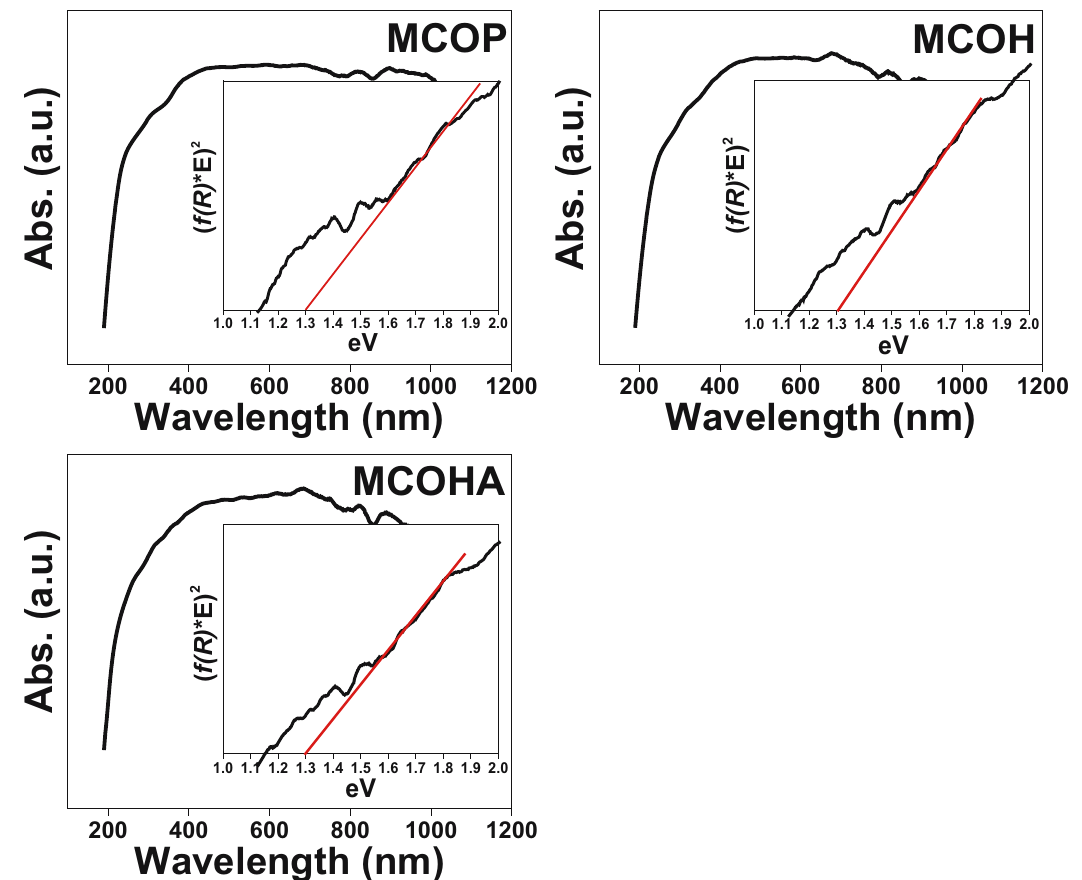
Figure 7: Absorption spectra and Tauc plots for the estimation of the direct band gap for the MCOP, MCOH, and MCOHA.